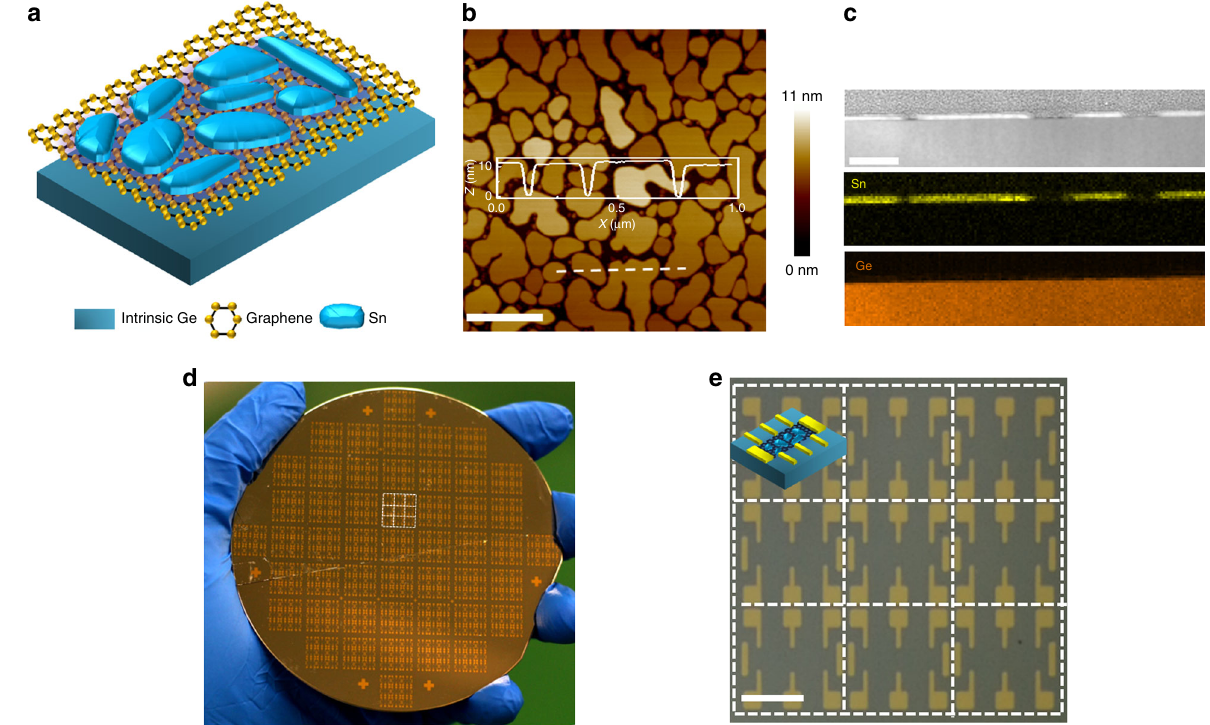
Fig. 1 Graphene – tin nanoislands hybrid system on 4 inch intrinsic germanium wafer. a Sketch illustration of the designed system consisting of tin nanoislands-decorated single crystalline monolayer graphene. b Atomic force microscopy (AFM) image of discontinuous tin islands with a uniform thickness of 10 nm self-assembled on single crystalline graphene. The scale bar is 500 nm. Inset: The depth pro fi le along the white dash line in Fig. 1b. c STEM image of the cross sectional 10 nm-thick discontinuous tin-nanoislands on the graphene, and the corresponding STEM-EDS mapping images revealing the distributions of Sn and Ge. The scale bar is 100 nm. d Photograph of the test device matrixes fabricated on 4 inch intrinsic germanium wafer. e Magni fi ed view from d shows nine individual superconducting devices assembled into one array. The scale bar is 2